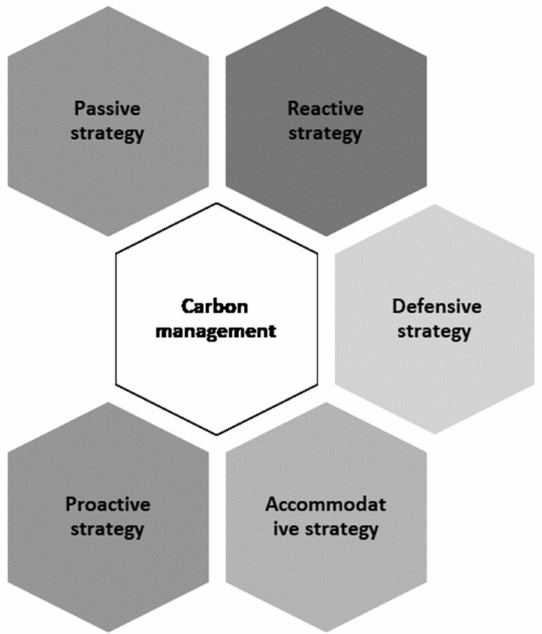
Figure 2. Strategic STAGEs of carbon management defined in this study. (Source: depicted by the